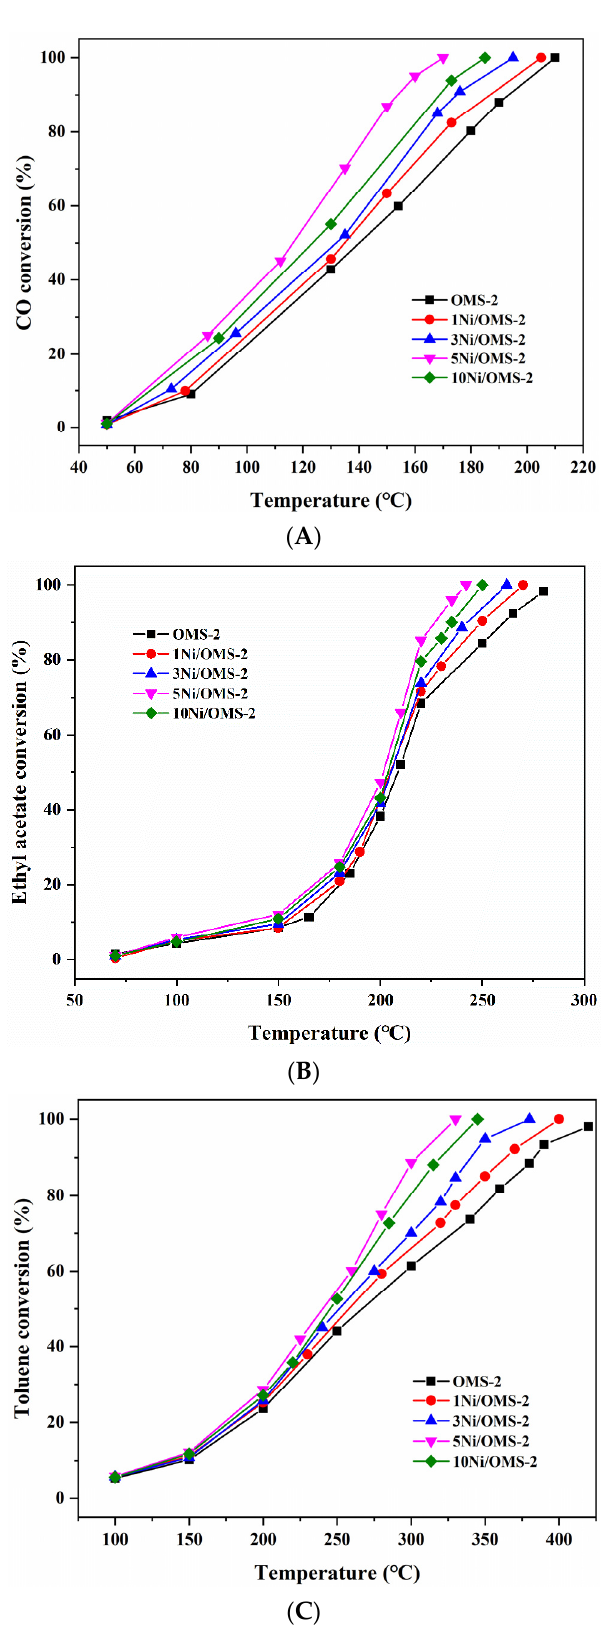
Figure 9. Catalytic activity of the OMS-2 and x Ni/OMS-2 samples for the oxidation of ( A ) CO at SV = 60,000 mL/(g·h), ( B ) ethyl acetate at SV = 240,000 mL/(g·h), and ( C ) toluene at SV = 240,000 mL/(g·h).